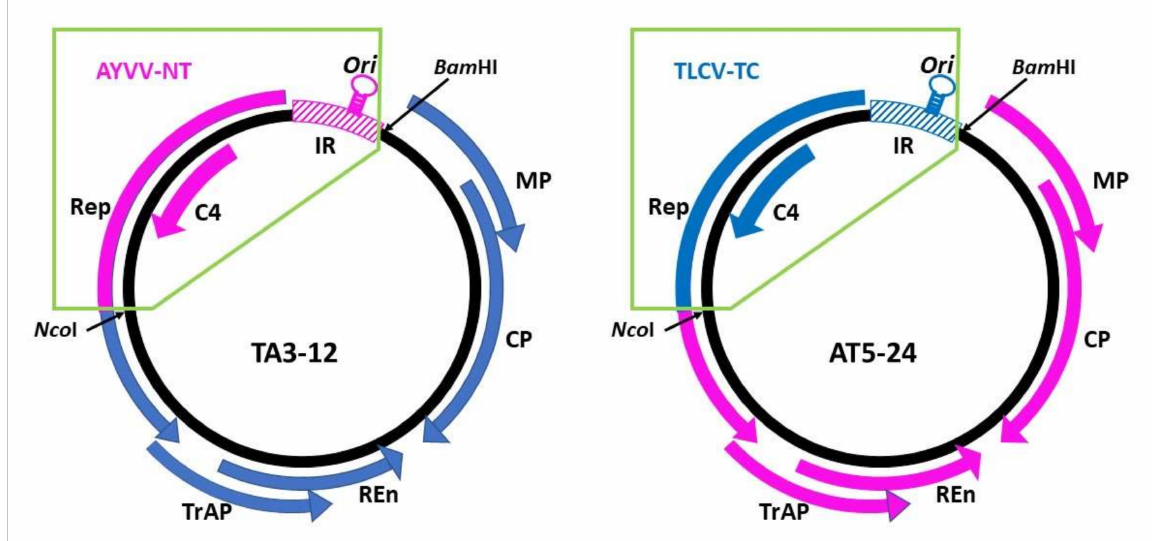
Figure 2. Schematic representation of the construction of chimeric begomovirus between AYVV-NT and TLCV-TC. The circular genomes of the representative chimeric begomoviruses, TA3-12, and AT5-24 were shown, with the genome fragment from AYVV-NT in pink and that from TLCV-TC in blue. The six open reading frames on viral genome were shown as the arrows, with the direction of translation represented by the arrow-head. The identities of the open reading frames were indicated. The restriction enzyme recognition sites, Bam HI and Nco I, used for the construction of the chimeric virus were specified. The intergenic region, IR, and the origin of replication ( Ori ) were represented by the hashed box and the stem-loop,